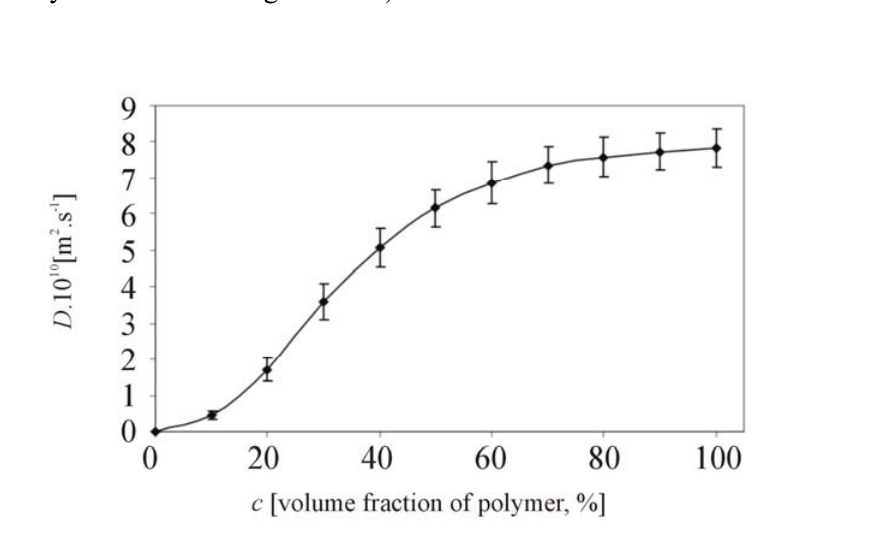
Figure 2. Dependence of mutual diffusion coefficient on concentration of polymer (the example of hyaluronan swelling at 37